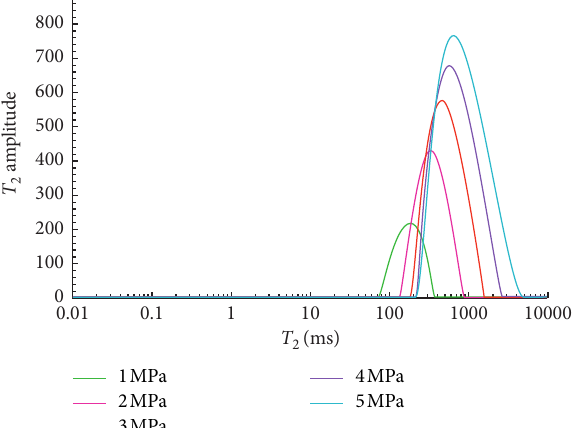
Figure 6: Pore radius distribution of raw coal.